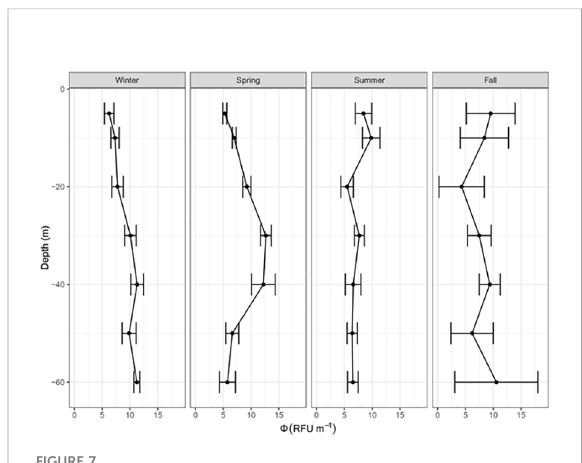
FIGURE 7 Vertical distribution of the quantum yield of fl uorescence, F (RFU m -1 ), for the Med-Bouss dataset for each season and each sampling depth.